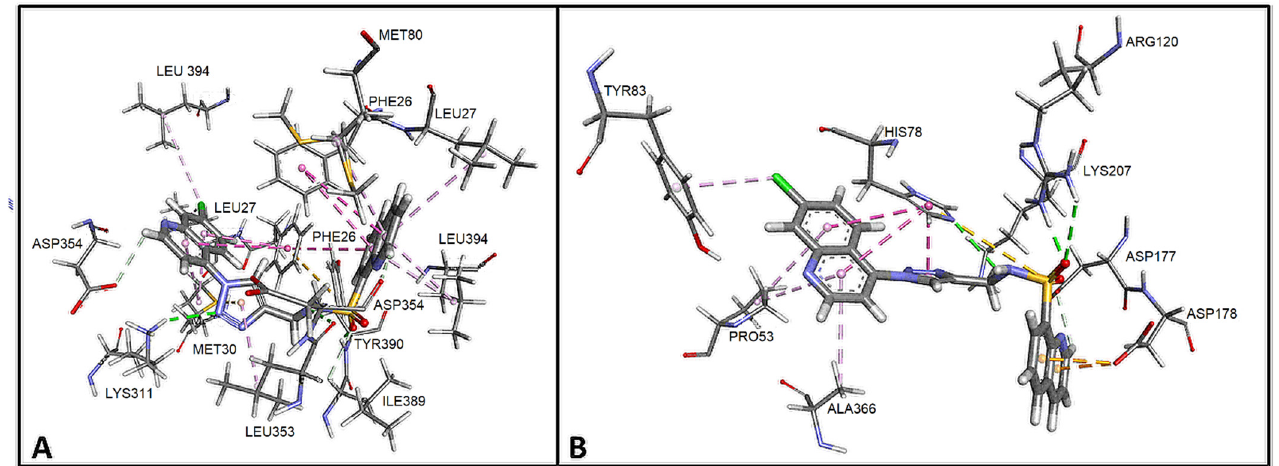
Figure 5. Three-dimensional representation of docked molecule 9a and its interactions on the active site of PKM2 ( A :PDB ID 4G1N, B : PDB ID 4FXF).